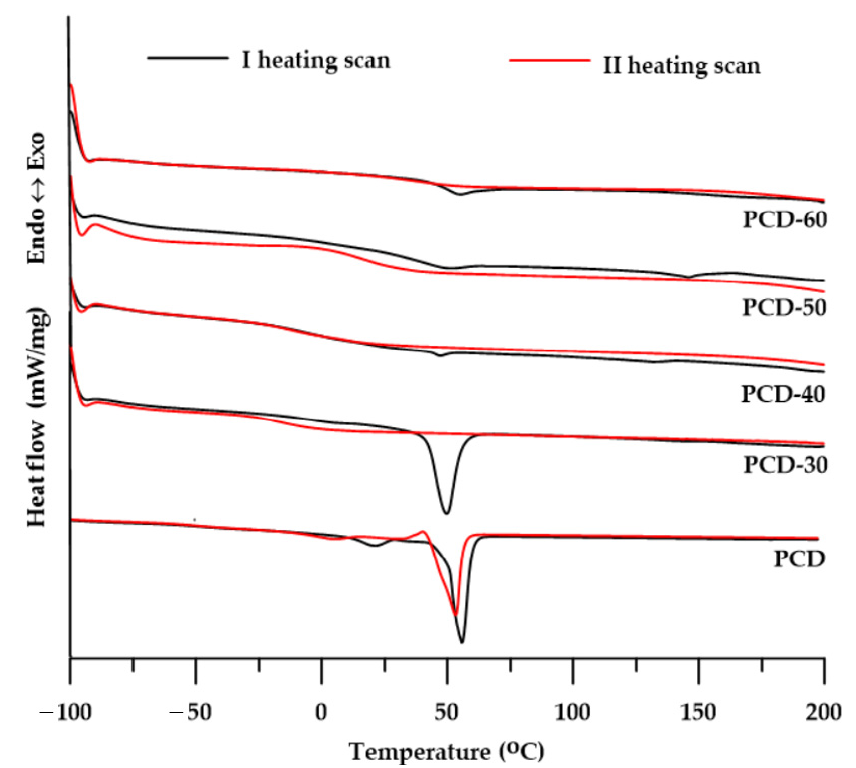
Figure 6. DSC curves of the synthesized polymers.